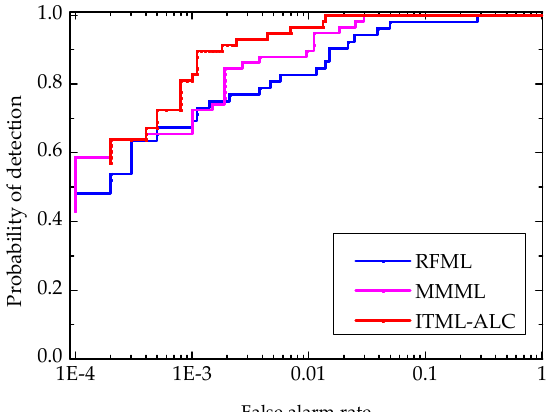
Figure 11. ROC curves of the different algorithms for AVIRIS San Diego airport dataset.